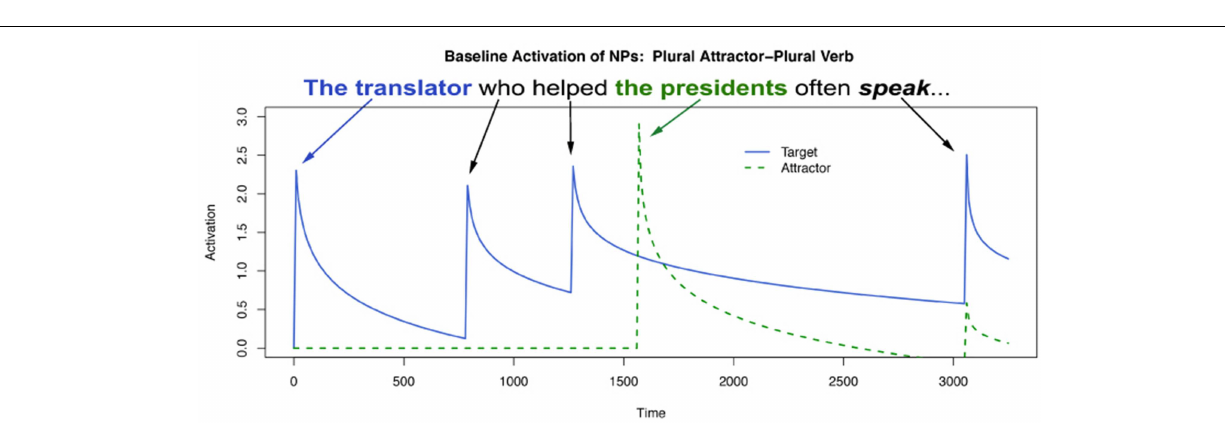
2014) with the number cue present on the main clause